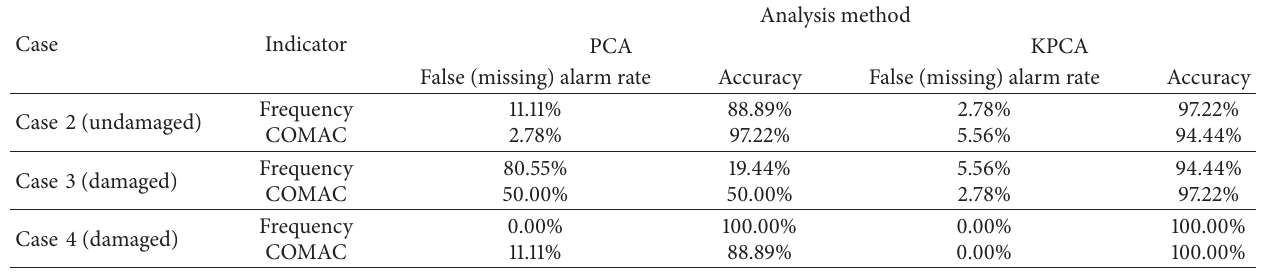
Table 1: The comparison of false alarm rate and missing alarm rate of PCA and KPCA method.